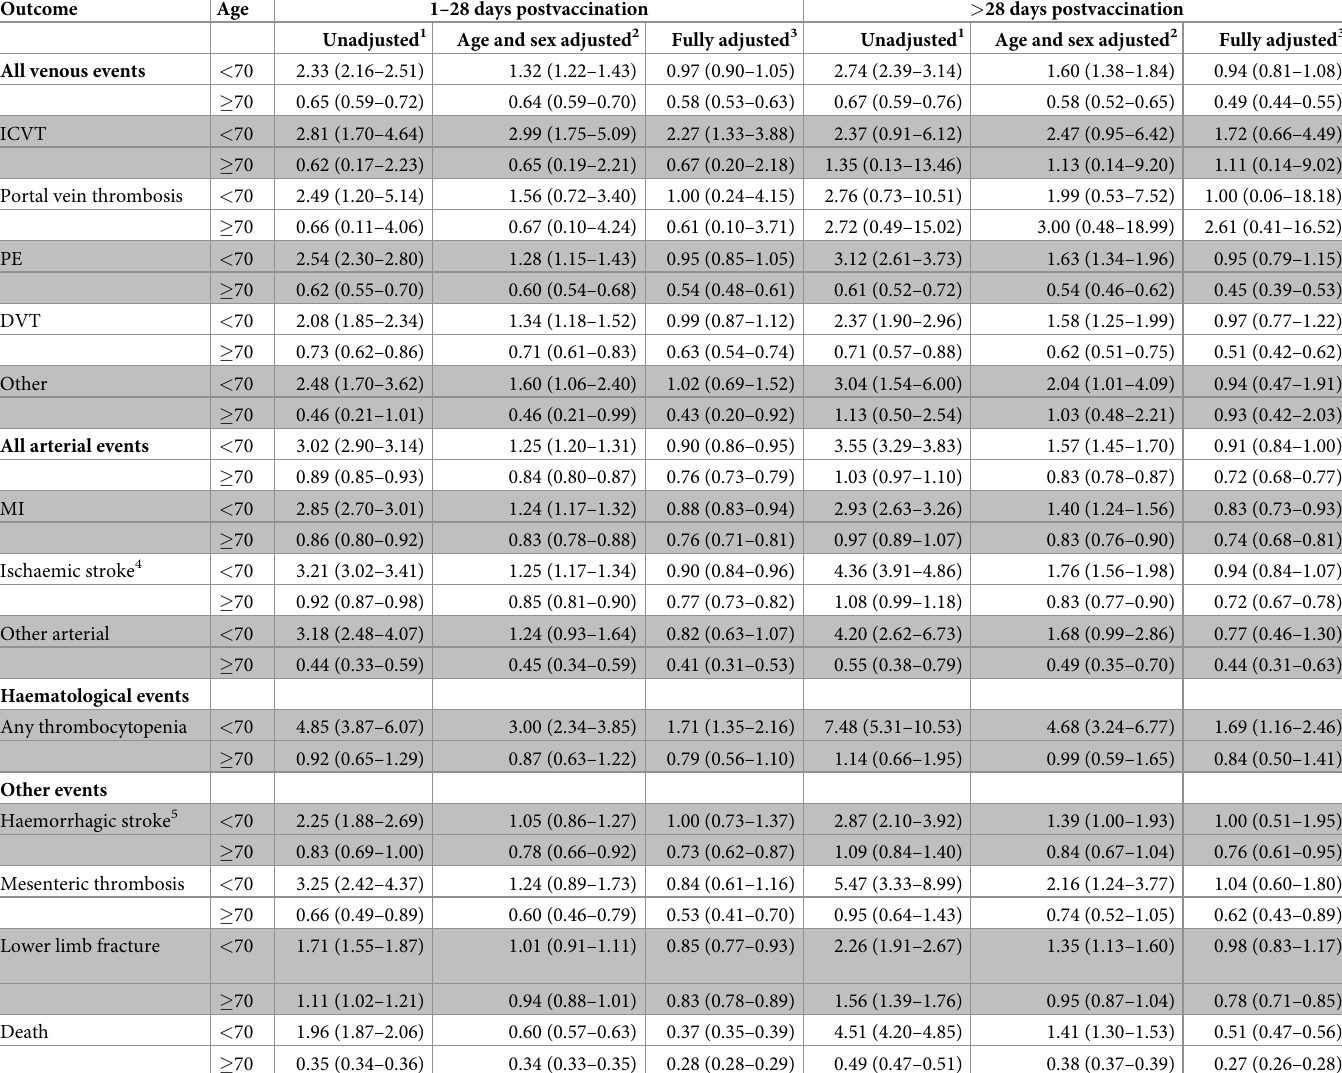
Table 4. HRs (95% CIs) for thrombotic and other outcomes 1–28 and > 28 days postvaccination with ChAdOx1-S vaccine, compared with prevaccination rates. All analyses were stratified on geographical